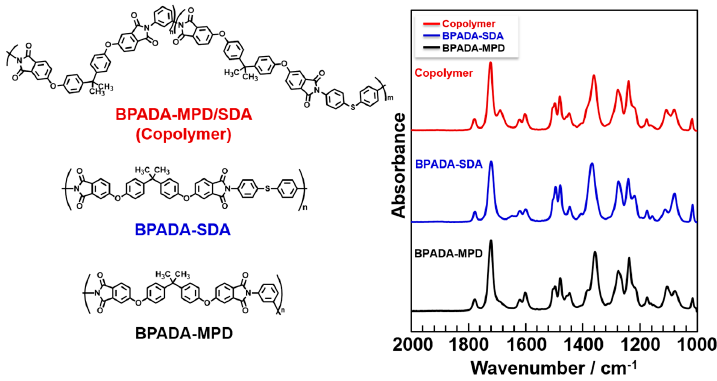
Figure 3. Structures and ATR-FT-IR spectra of PI (BPADA-SDA/MPD, BPADA-SDA, and BPADA-MPD) films.